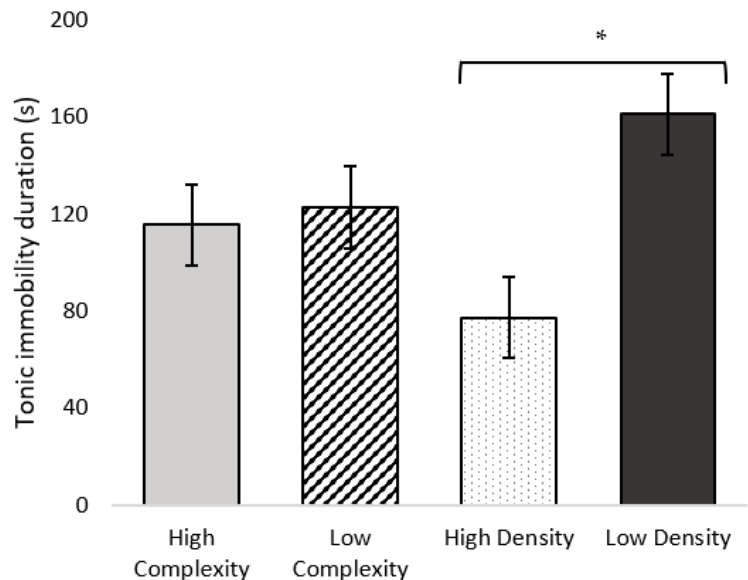
Figure 5. Least squares mean estimates (s ± SEM) for tonic immobility duration (0–300 s) for broiler chickens ( n = 71) kept in high-complexity, low-complexity, high-density, and low-density treatments in Experiment 2 on day 19 of age. * p < 0.05.